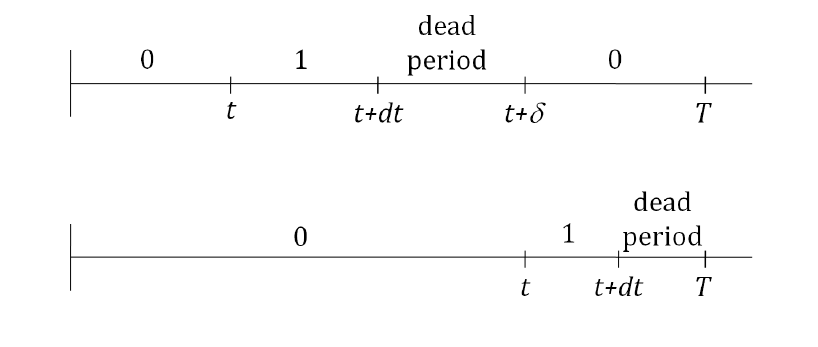
Figure 3. Two configurations leading to recording one photon by time T